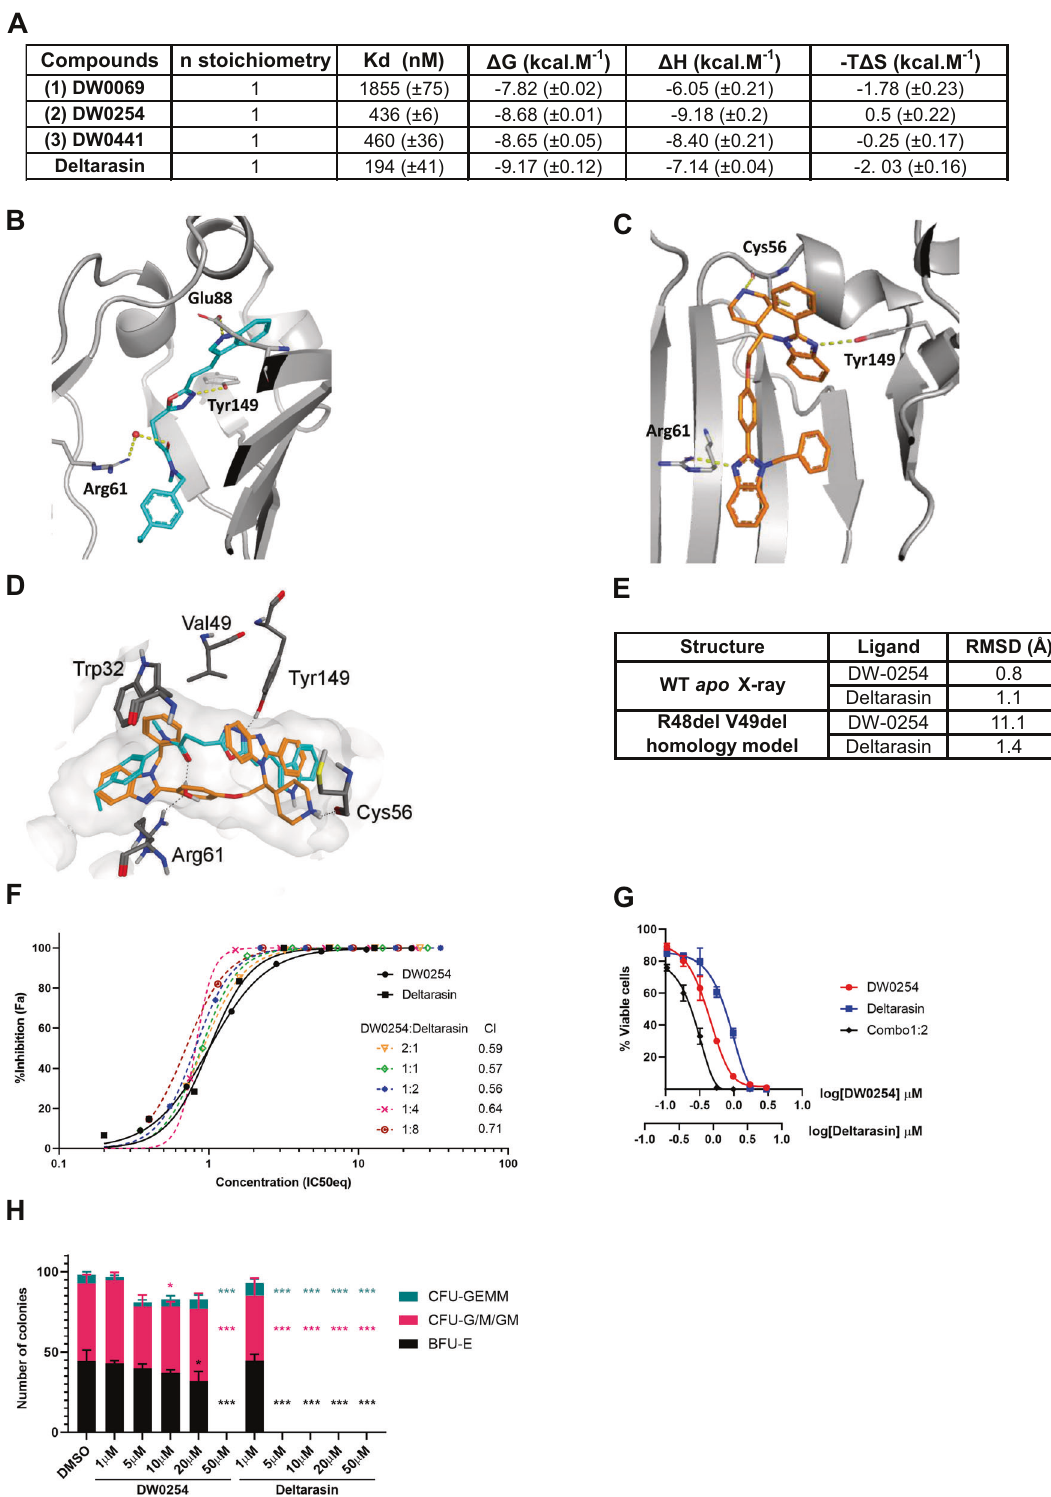
pathways including MAPK/ERK, PI3K/AKT, and consequently RAC. However, we observed the same range of inhibition of RAS downstream pathways upon DW0254 treatment in both sensitive and resistant cell lines. This result implies that kinase pathways inhibition downstream of RAS delocalization does not uniformly associate with decreased cell viability in acute leukemia cell